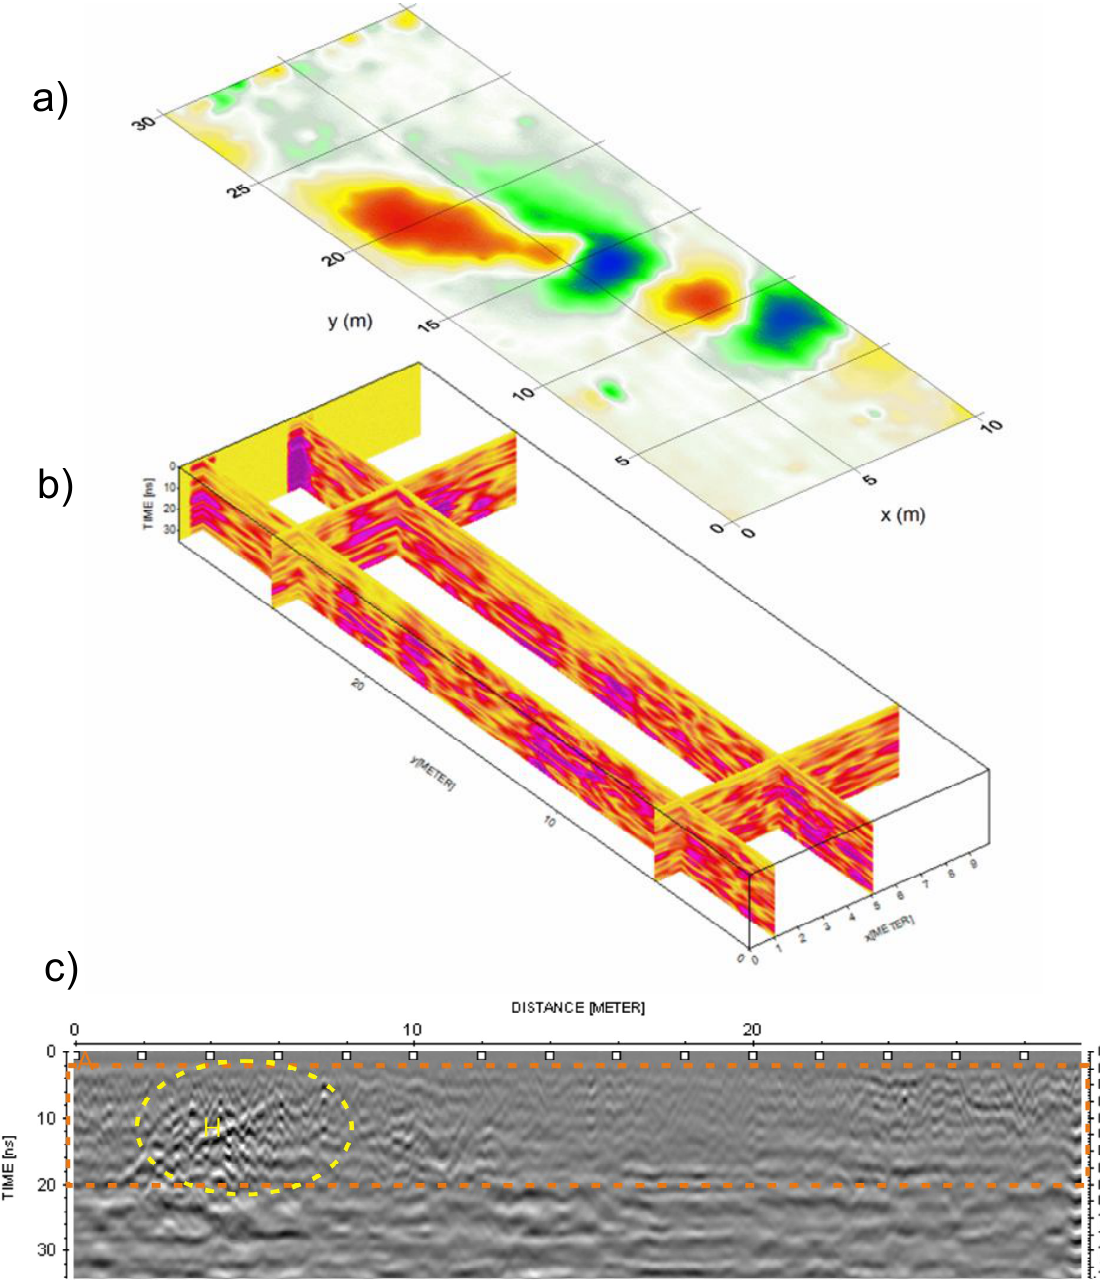
Fig. 7. Geophysical data acquired in “Monastero2” site. (a) magnetic map; (b) radargram; (c) pseudo-3-D GPR